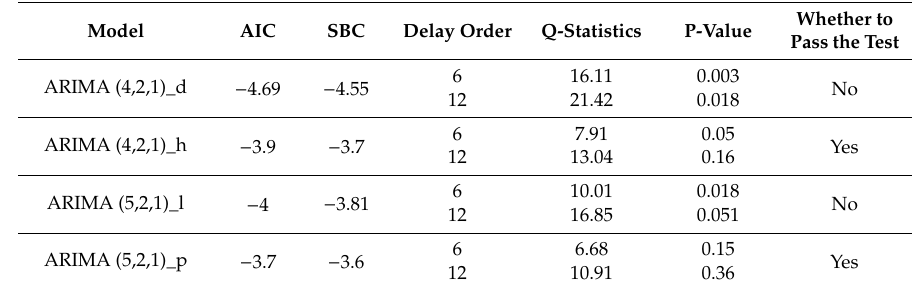
Table 5. White noise test results and Akaike Information Criterion (AIC) and Bayesian Information Criterion (SBC) values of the residual